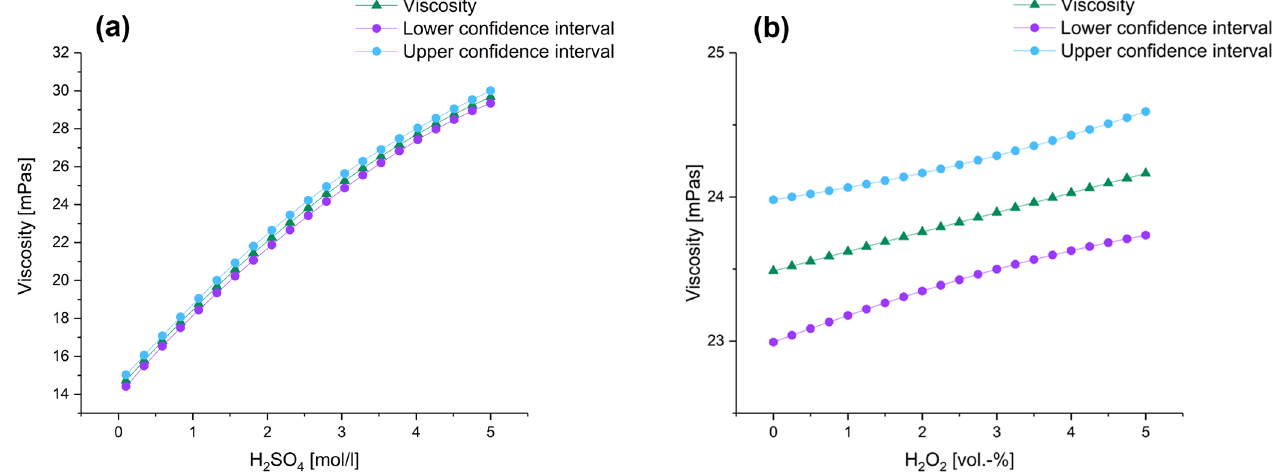
Figure 6. Viscosity dependency on the concentration of ( a ) the leaching medium (H 2 SO 4 ) and ( b ) the reducing agent (H 2 O 2 ) with parameters at otherwise average values (60 °C, 75 g/L solids, 240 min), confidence interval of 95%.